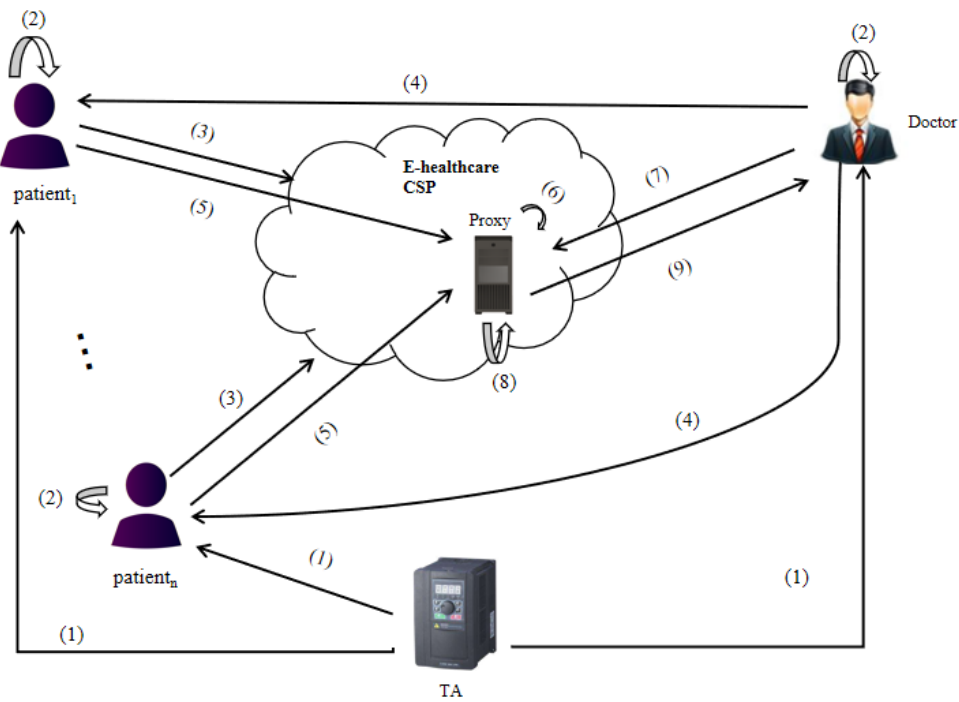
Figure 3. Secure computing of personal healthcare records (PHRs) using HPRE with strong anti- collusion (SAC) in the